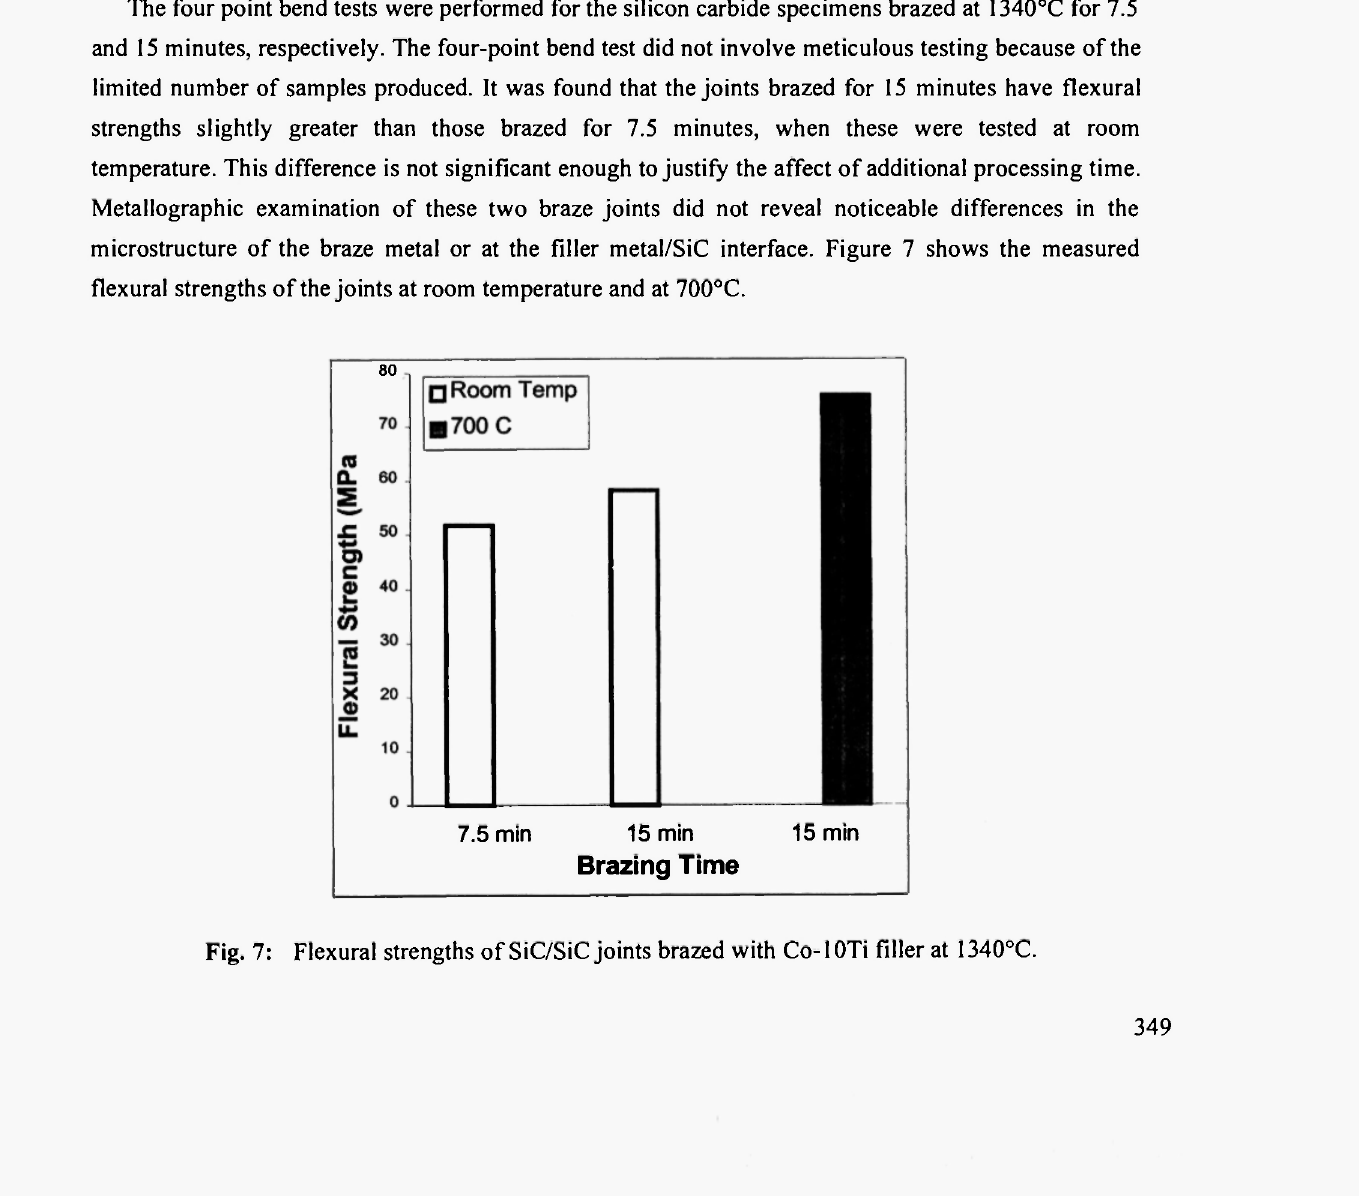
Fig. 7: Flexural strengths of SiC/SiC joints brazed with Co-10Ti filler at